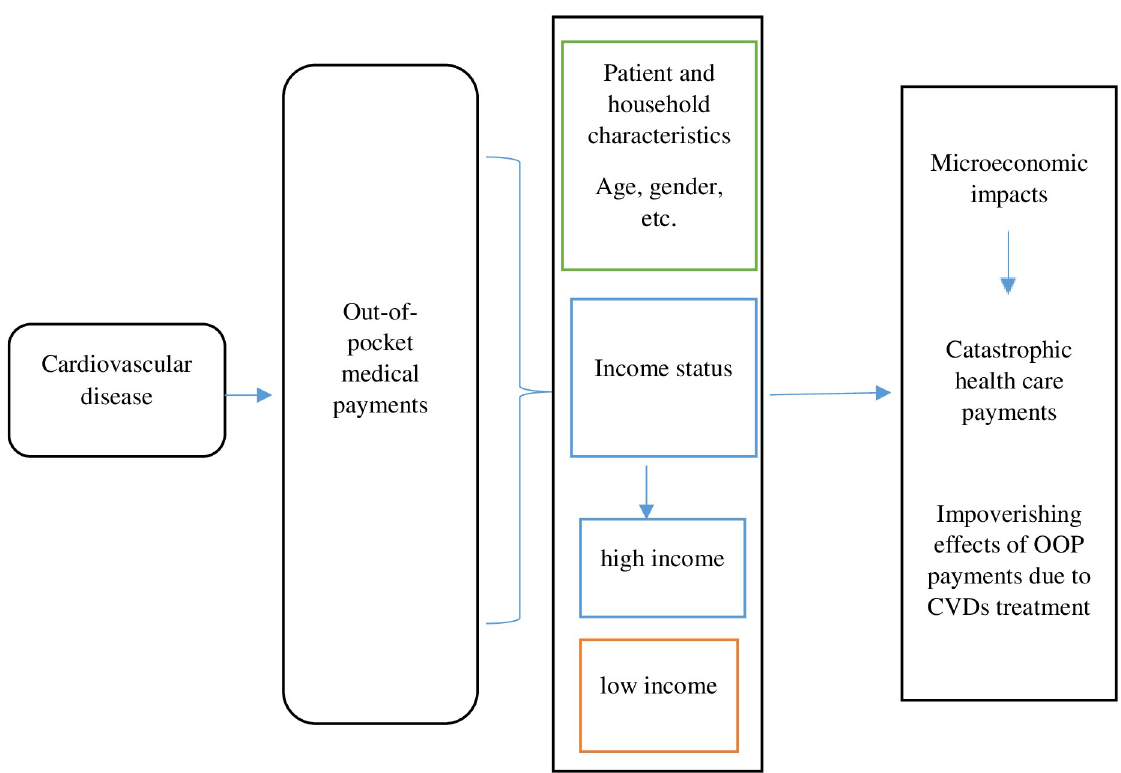
Fig 1. The microeconomic impact of cardiovascular disease on individuals and households. Adapted from McIntyre et al. 2006, pp. 860.